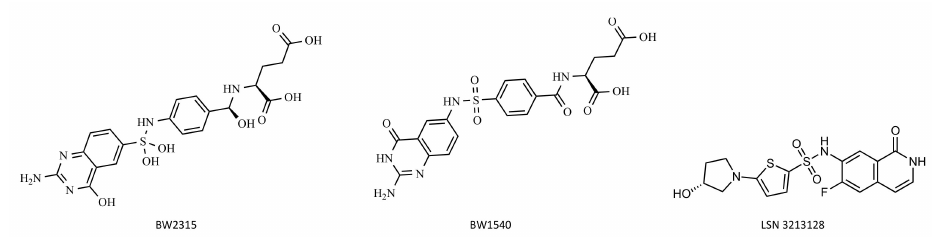
Figure 8. Chemical structure of AICAR TFase